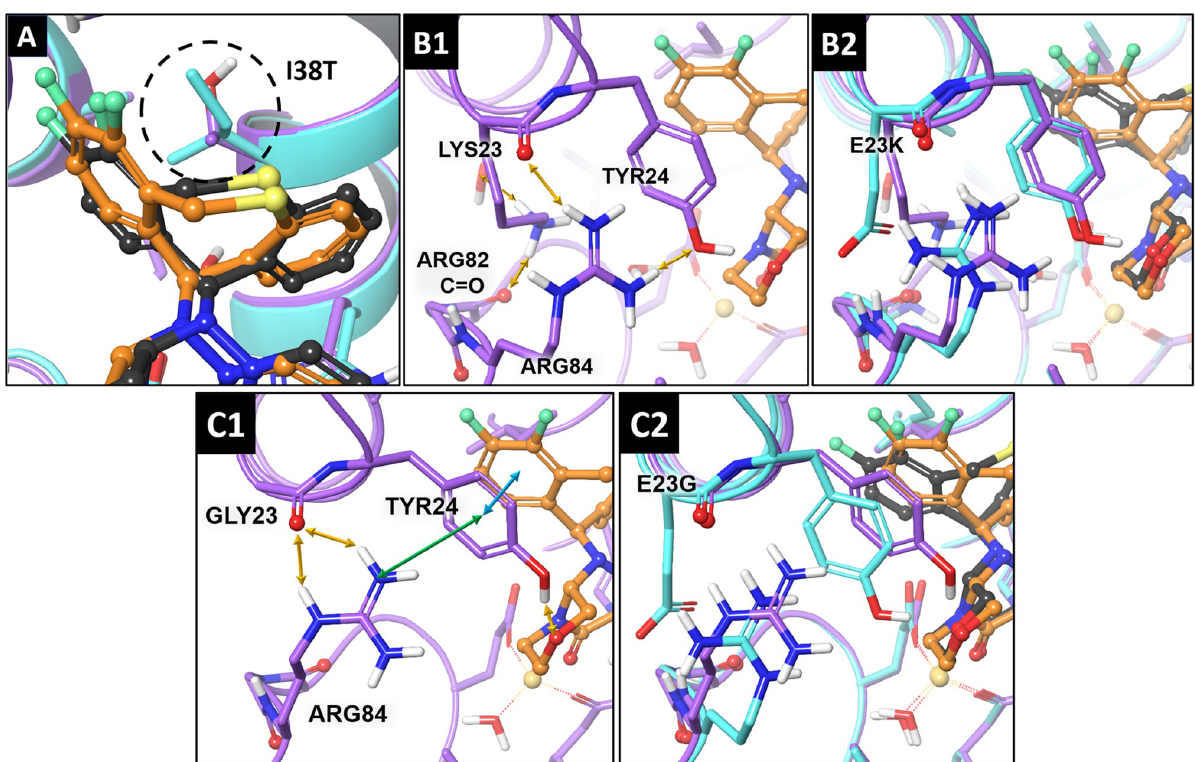
Fig 7. Modeling of the BXA-rPA N binding interface of A(H1N1)pdm09 with E23G/K. A) The I38T substitution (dotted circle) leads to a significant decrease in van der Waals interactions between residue 38 and the hydrophobic sulfur-containing tricyclic system of BXA. B1) structural perturbations caused by E23K lead to conformational shifts of Arg84 and Tyr24 residues. B2) The aligned binding interfaces of BXA in WT and E23K PA N . C1) Structural perturbations caused by E23G lead to conformational shifts of Arg84 and Tyr24 residues. C2) The aligned binding interfaces of BXA in WT and E23G PA N . Light blue tubes: WT PA N ; violet tubes: E23G/K-substituted PA N ; dark-gray balls and sticks: the BXA pose in WT PA N ; orange balls and sticks: the BXA pose in E23G/K-substituted PA N ; gold arrows: hydrogen bonds; blue arrows: π -stacking interactions; green arrows: π -cation